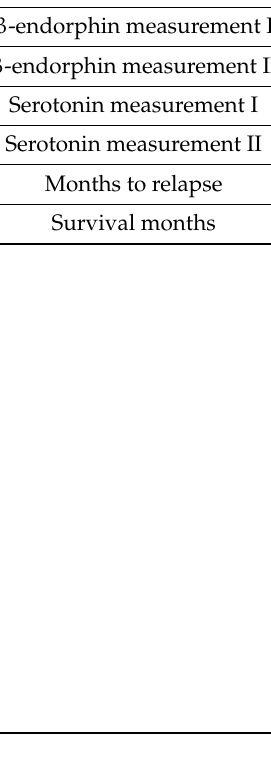
Table 1. Basic descriptive statistics of the researched quantitative variables. M Me SD Sk. Kurt.